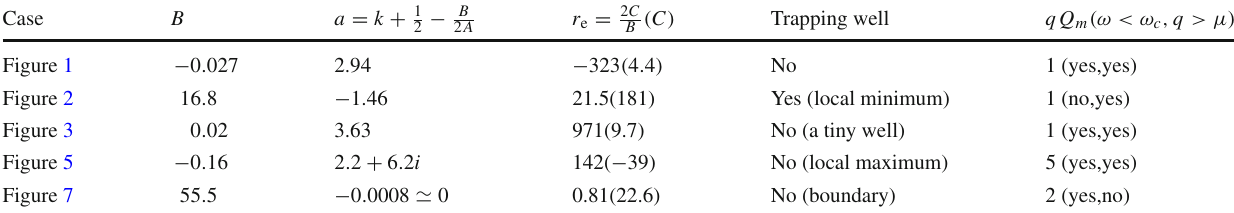
Table 1 Results for asymptotic potential V aadR ( r ) and far-region wave function analysis. All cases satisfy the condition for an asymptotic bound state ( ω < μ ). B > 0 ( B < 0 ) represents the case that the grav- itational (electrostatic) force exceeds the electrostatic (gravitational) force. a < 0 ( a > 0 denotes the condition for a quasibound (bound) state. r e > r + with C > − 0 . 25 ( C < − 0 . 25 ) indicates the location of